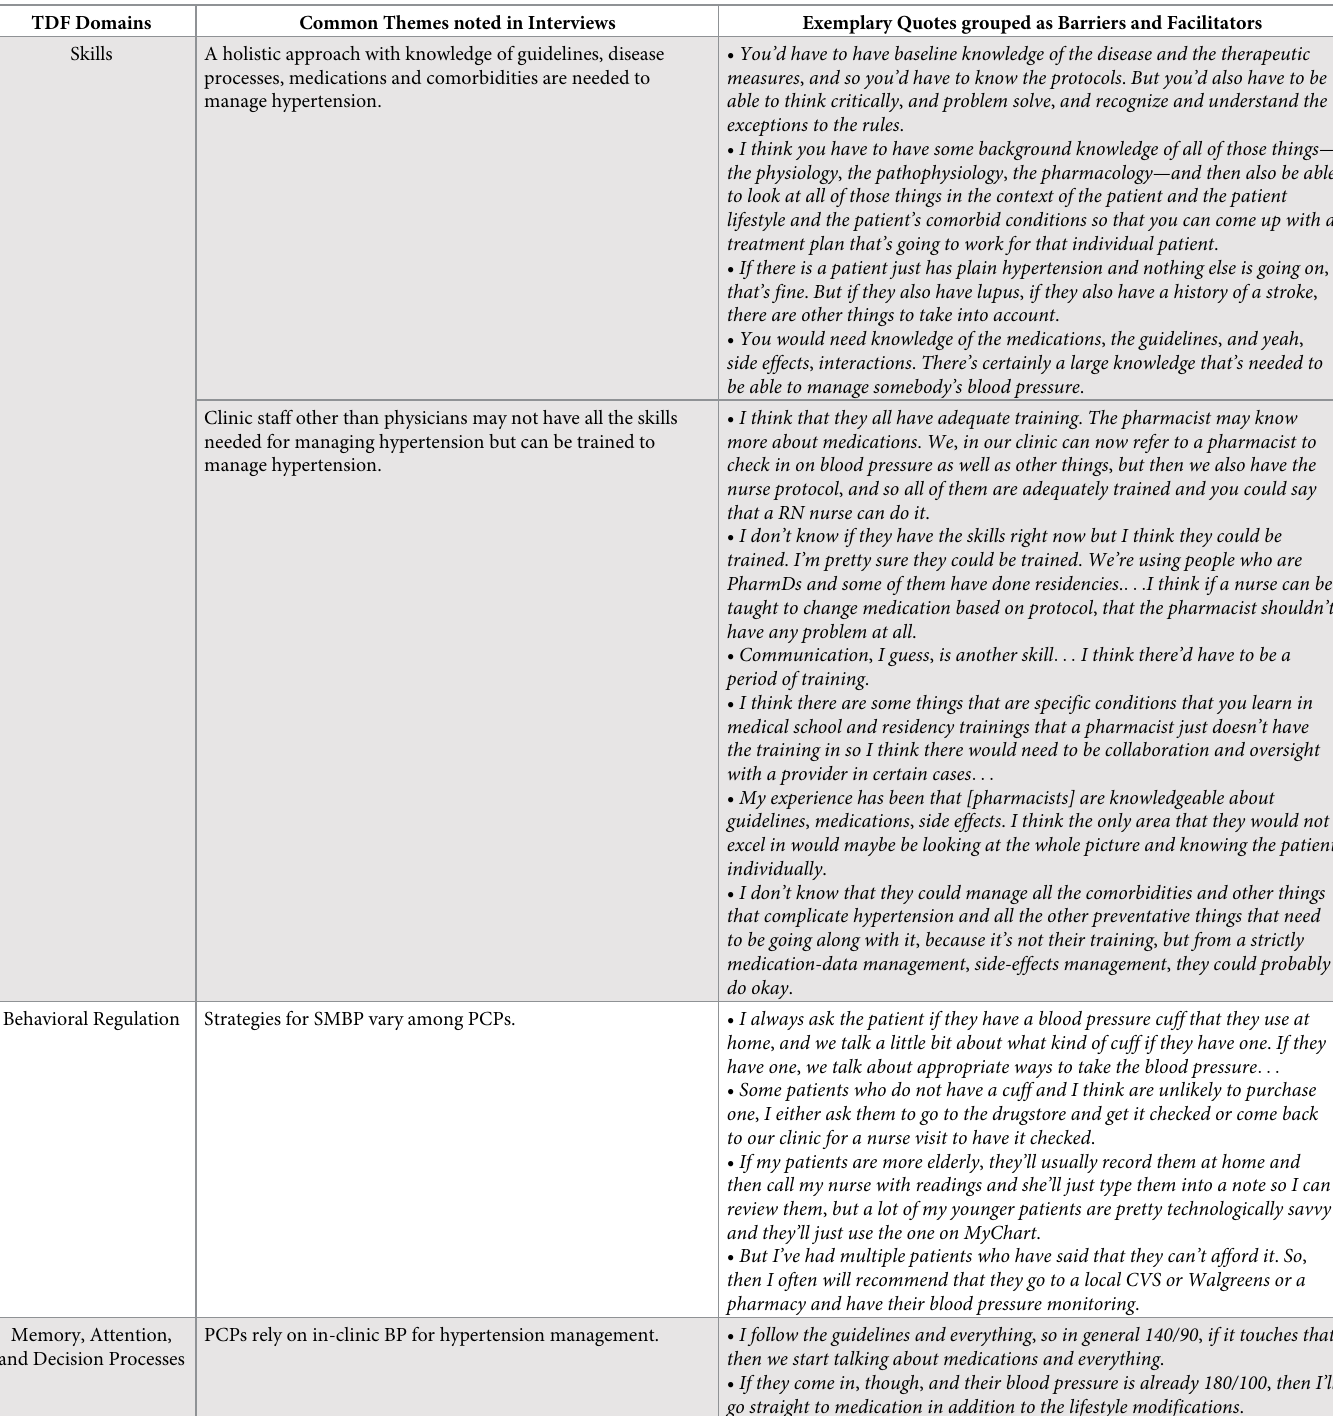
Table 4. Common themes and relevant quotes illustrating barriers and facilitators for capabilities